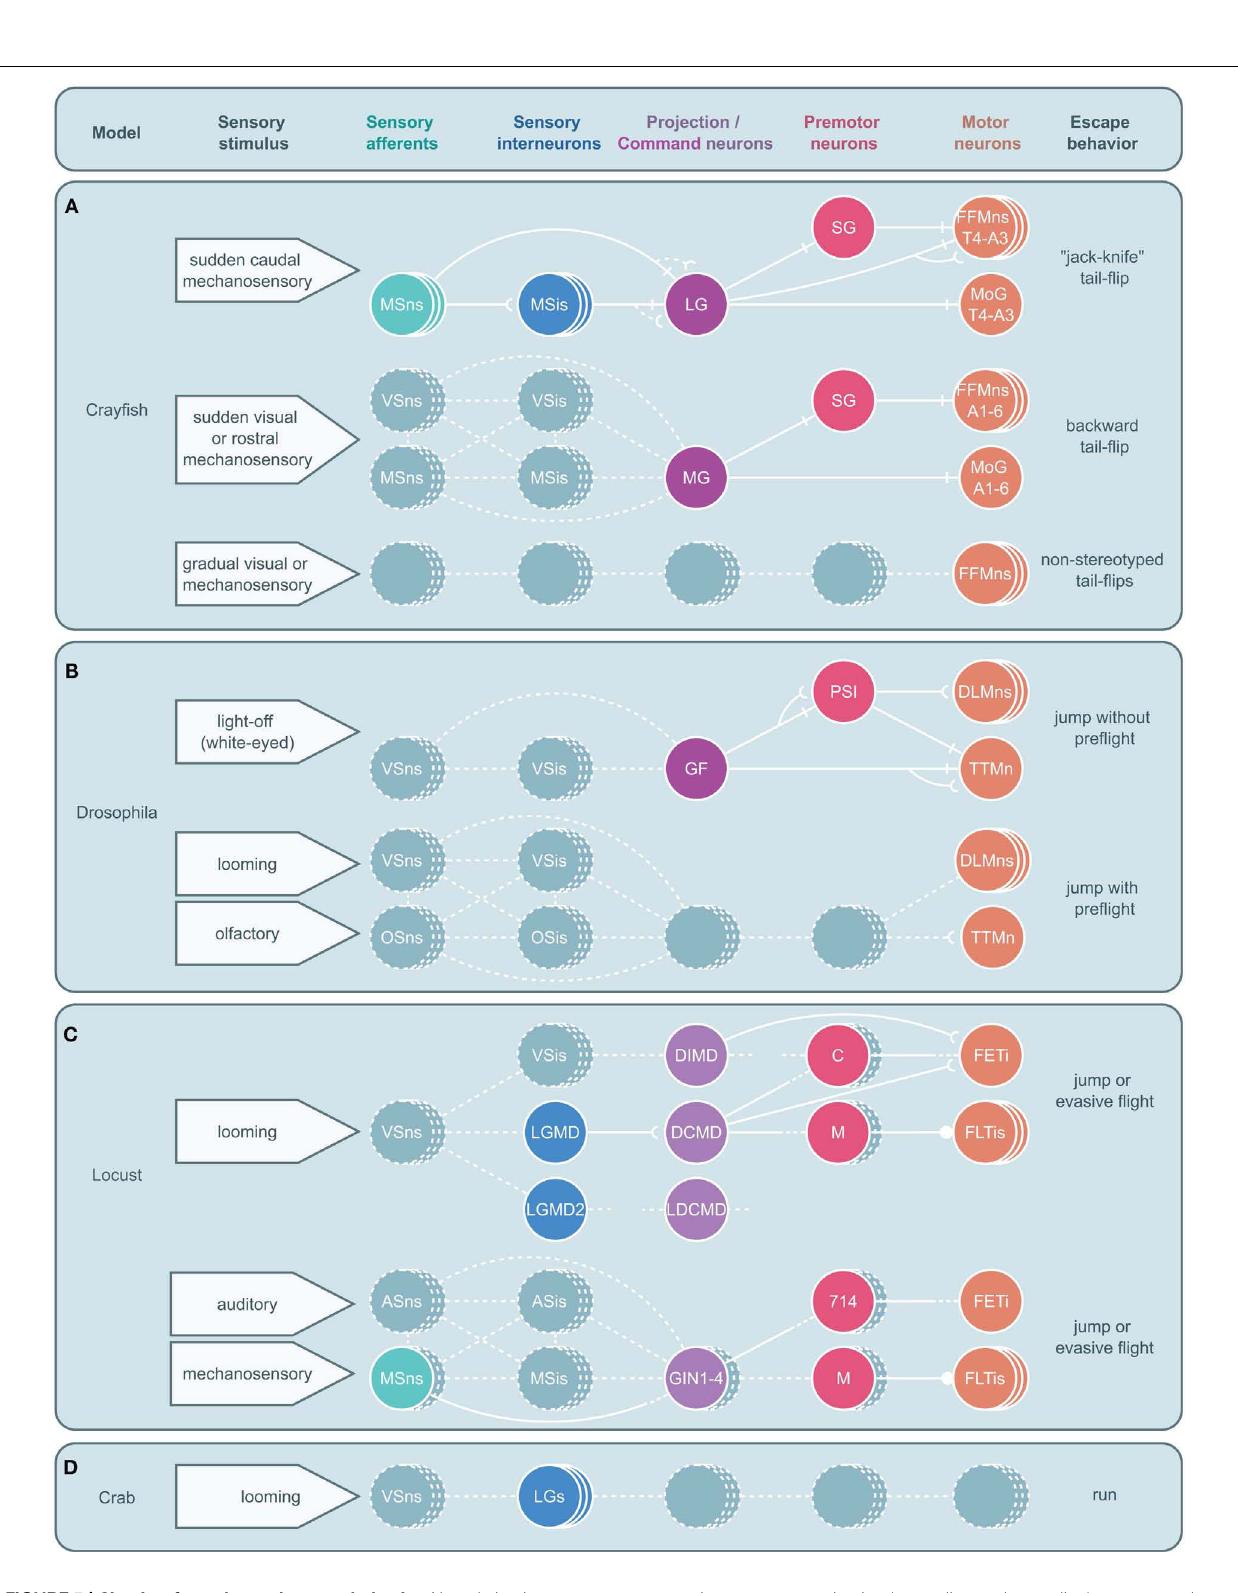
FIGURE 5 | Circuitry for arthropod escape behavior. Neural circuits underlying escape behaviors for crayfish (A) , Drosophila (B) , locust (C) , and crab (D) are illustrated. Circuits are divided into five levels: sensory neurons,